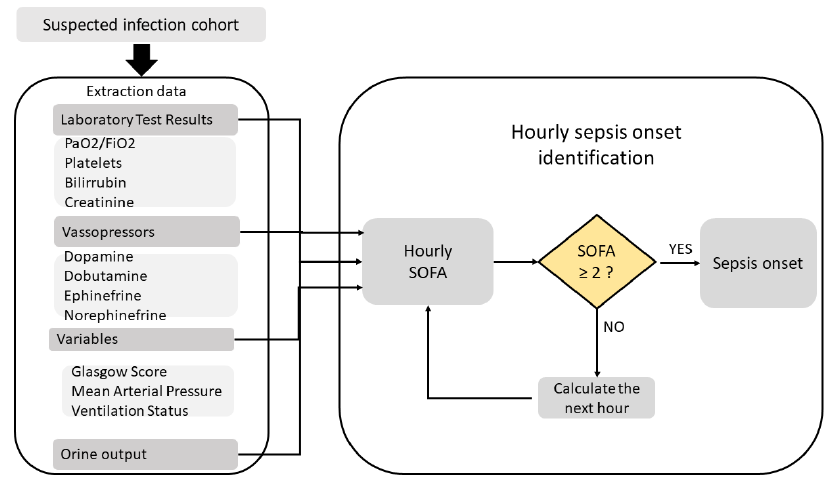
Figure 5. Sepsis-3 onset hourly computation.